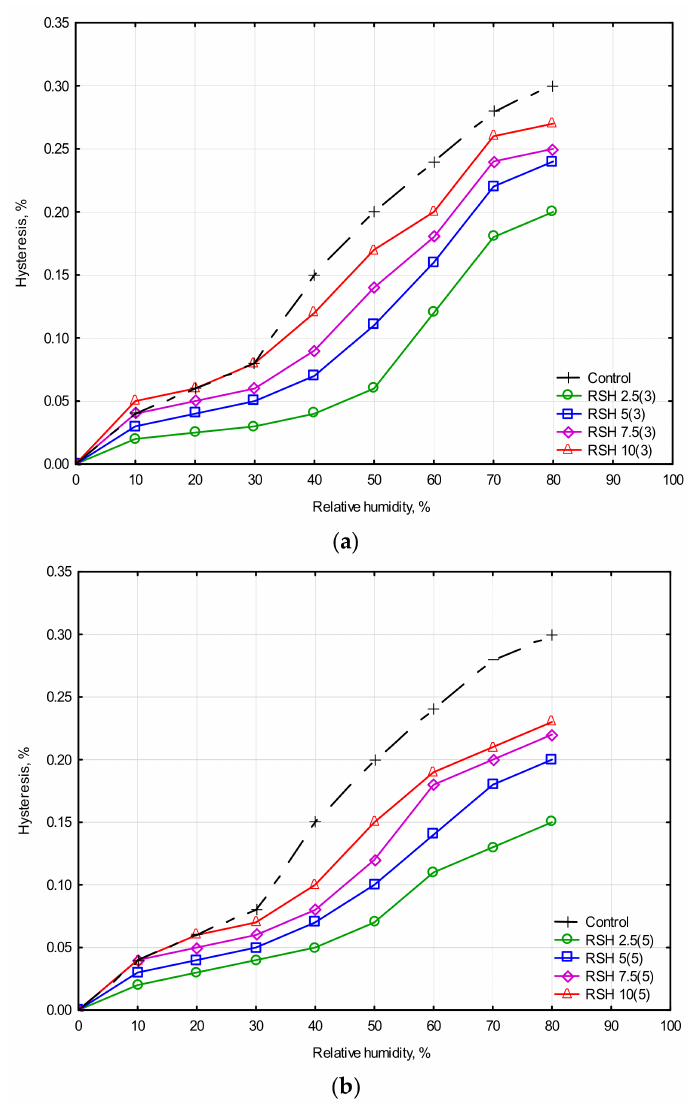
Figure 8. Hysteresis rate of stabilized clay composites: ( a ) RSH heat-treated for 3 h and ( b ) RSH heat-treated for 5